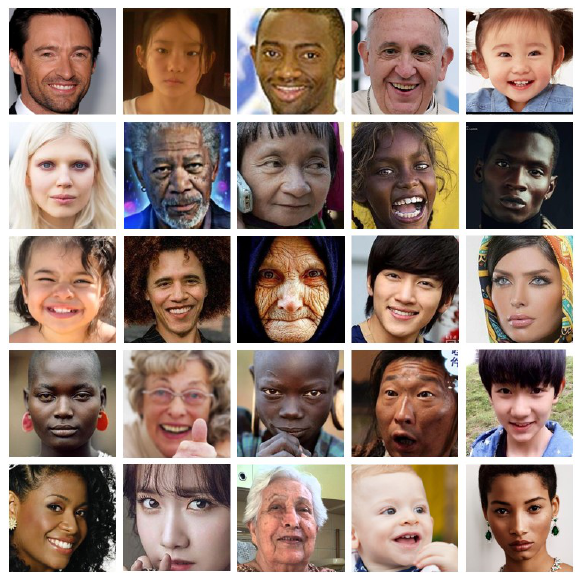
Figure 5. Sample images in the AffectNet, including faces of people of different races, ages and gen-